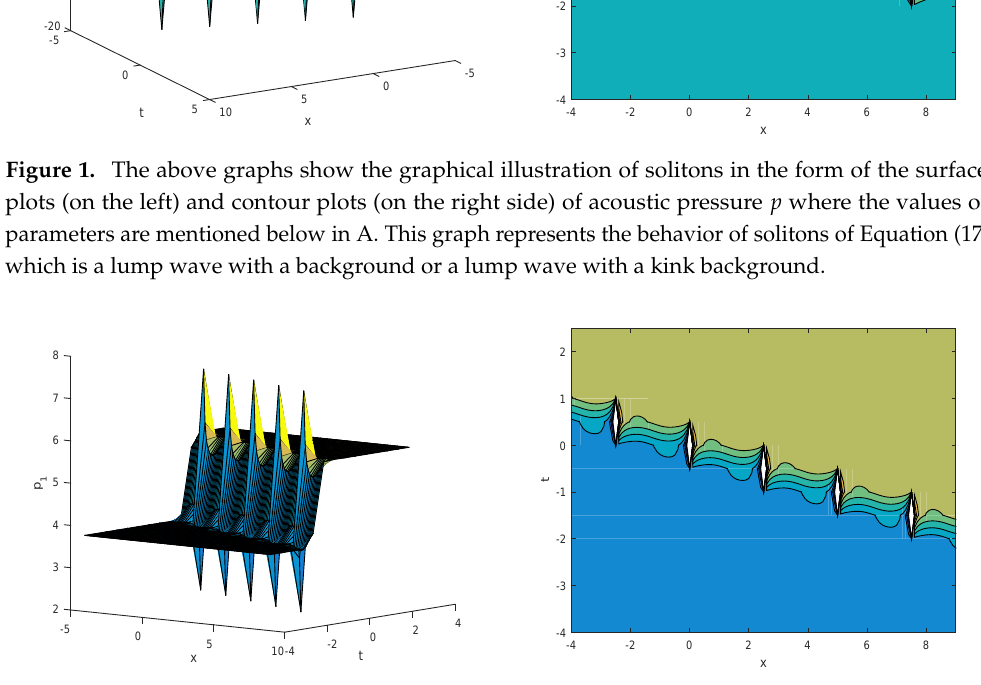
Figure 2. The above graphs show the graphical illustration of solitons in the form of the surface plots (on the left) and contour plots (on the right side) of acoustic pressure p where the values of parameters are mentioned below in B. This graph represents the behavior of solitons of Case I Equation (19) which is a mixed lump train wave with a kink background, the dynamical feather wave (as velocity and amplitude) has retained the same value along the